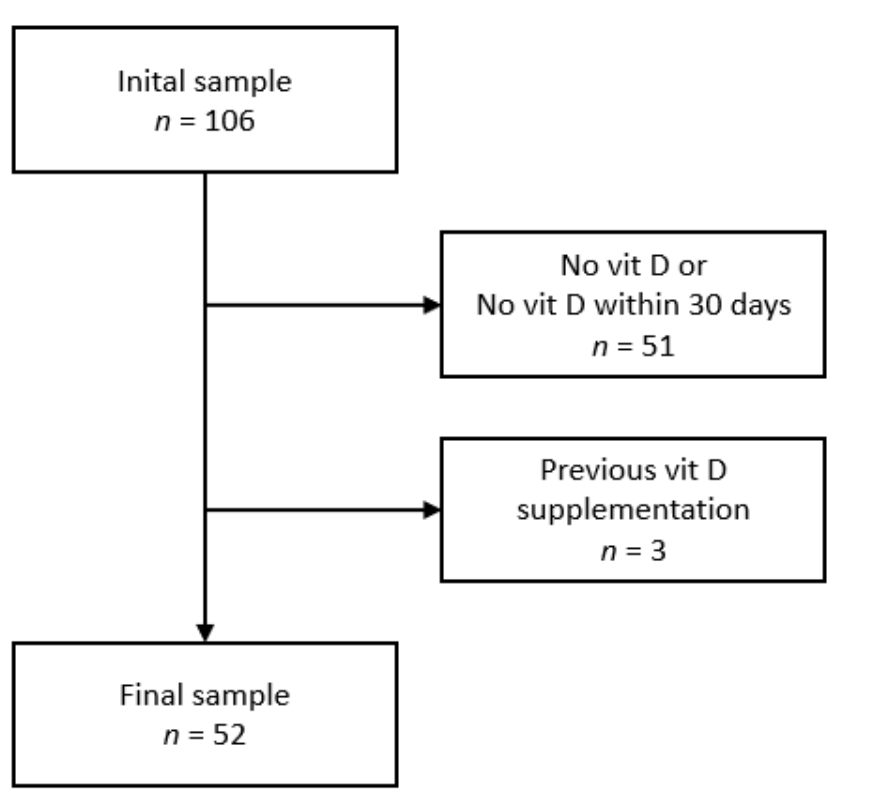
Figure 1. Selection procedure. Table 1. Characteristics of the participants according to